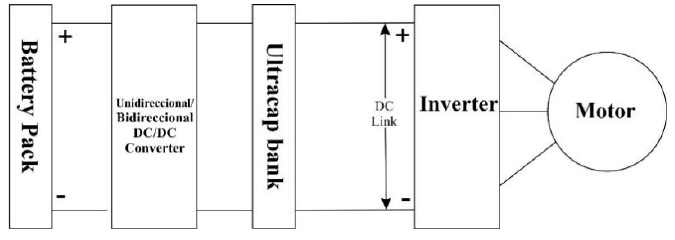
Figure 3. Battery/ultracapacitor configuration [7].